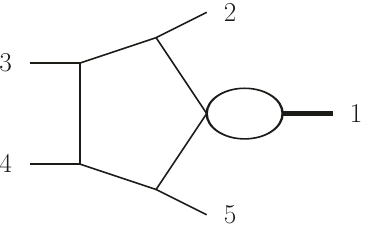
Figure 2. One-loop squared integral family ( 1L 2 ) appearing in the computation of two-loop five- particle amplitudes with a single external massive